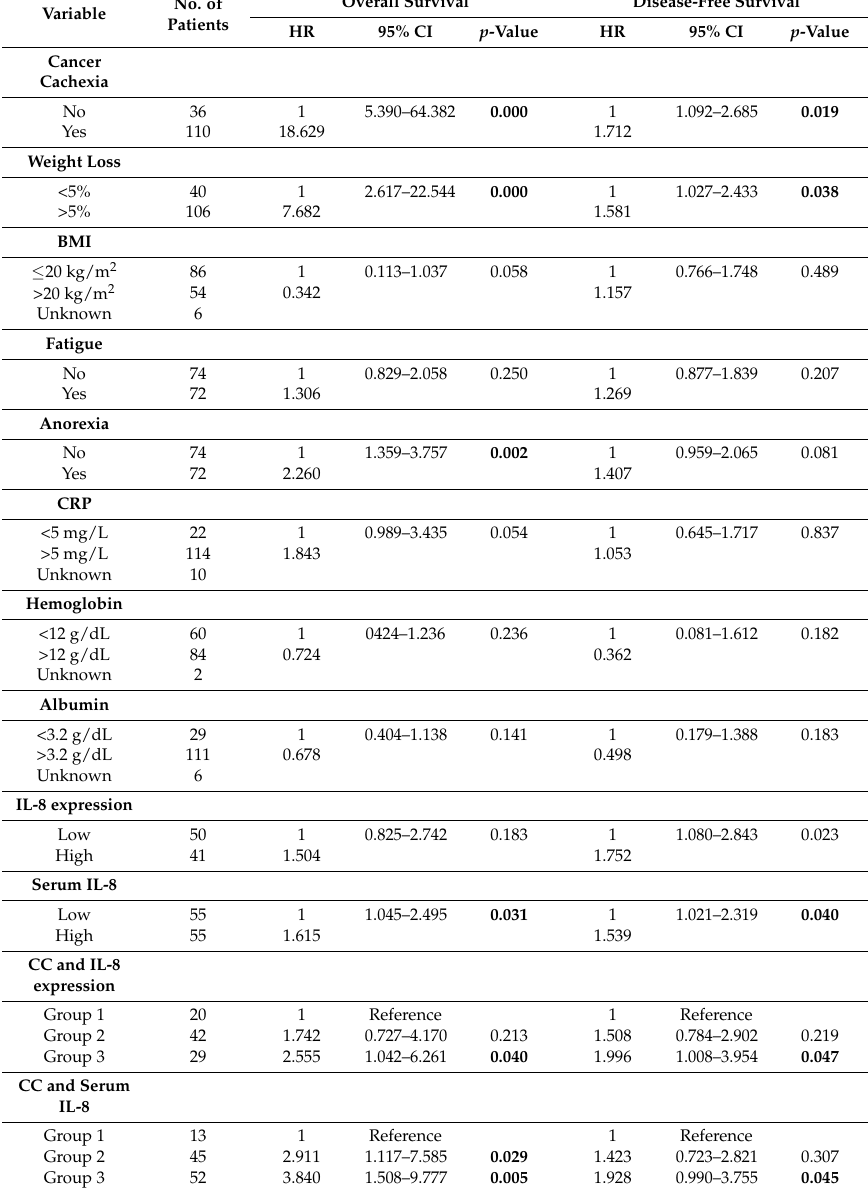
Table 3. Prognostic factors associated with survival in the multivariate